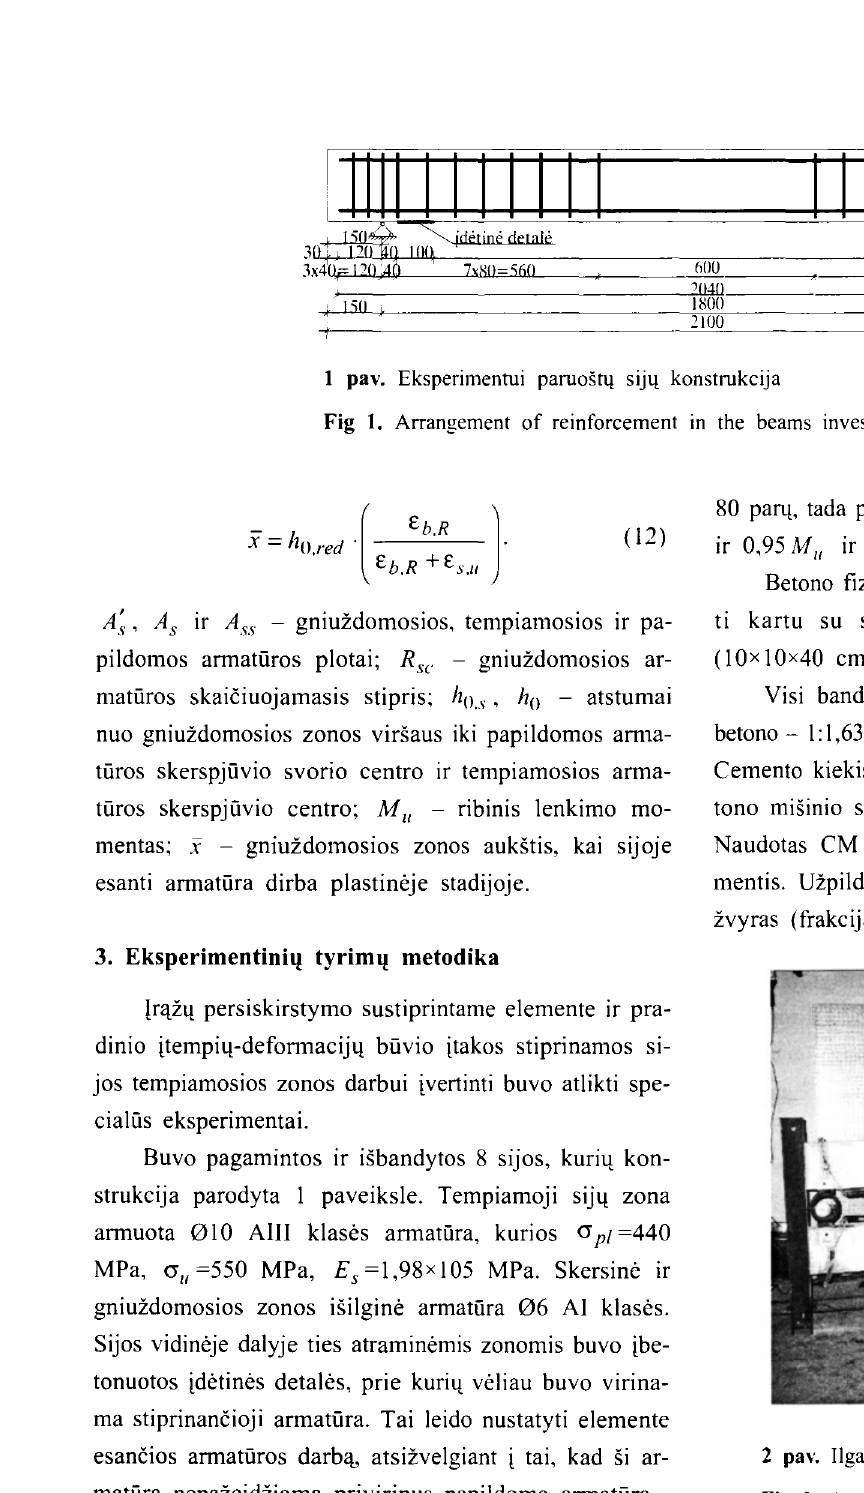
Fig 2. Application of long-term load to the beams in